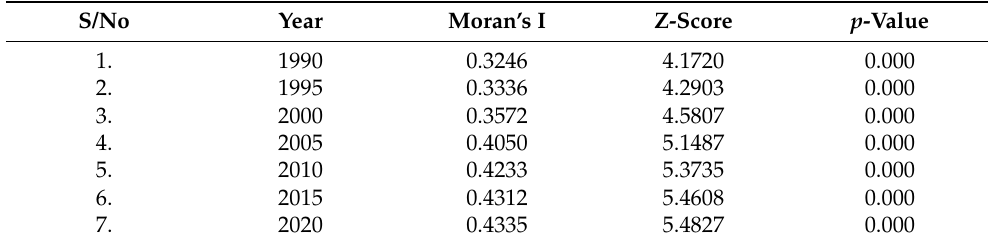
Table 2. Moran’s I index of urban expansion of counties in Zhejiang Province